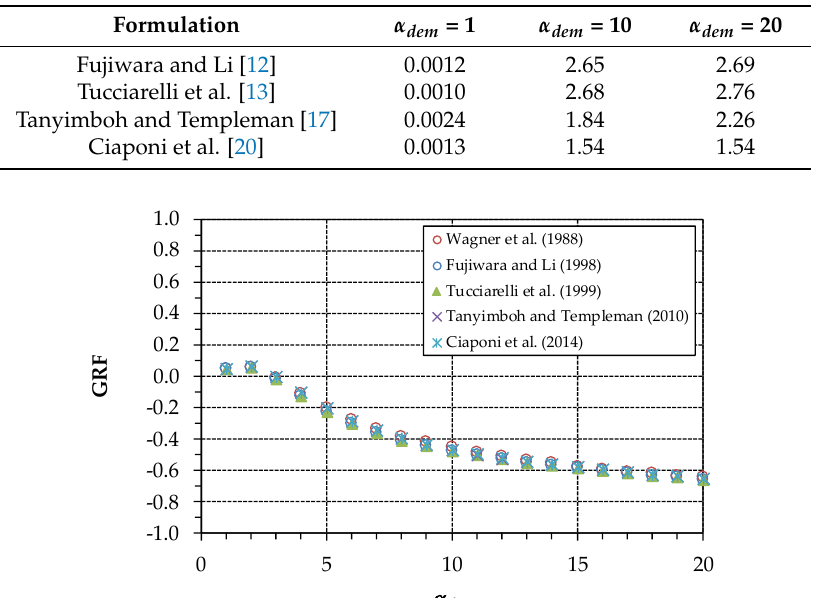
Table 2. First case study. Mean absolute deviation (m) of the various formulations in terms of nodal pressure head h compared to the Wagner et al. [9] formulation for the three values of α dem .